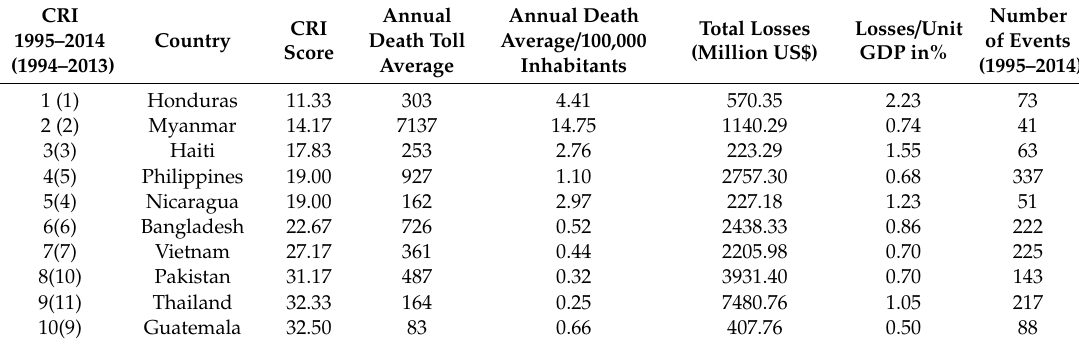
Table 1. The list of the top 10 countries most a ff ected in the Climate Risk Index (CRI; annual averages; adopted from [14]) between 1995 and